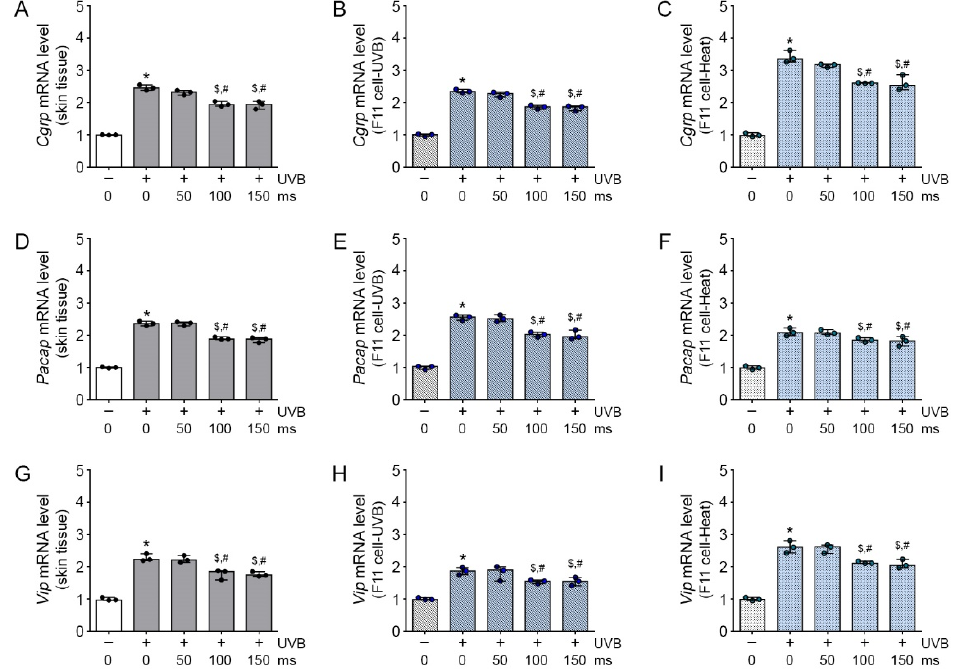
Figure 2. Inhibitory effects of RF on TRPV1-induced neuropeptide expression in UVB-exposed mice skin and UVB- or heat-treated sensory neuronal cells. ( A – I ) The TRPV1-induced neuropeptide ( Cgrp, Pacap, and Vip ) expression level was analyzed by qRT-PCR in the skin tissue ( A , D , G ) (3 mice per group), UVB exposure F11 cell model ( B , E , H ) and heat exposure F11 cell model ( C , F , I ) and were normalized to that of Actb and expressed relative to the control group. * p < 0.05 vs. Control; $ p < 0.05 vs. UVB or Heat; # p < 0.05 vs. RF 50